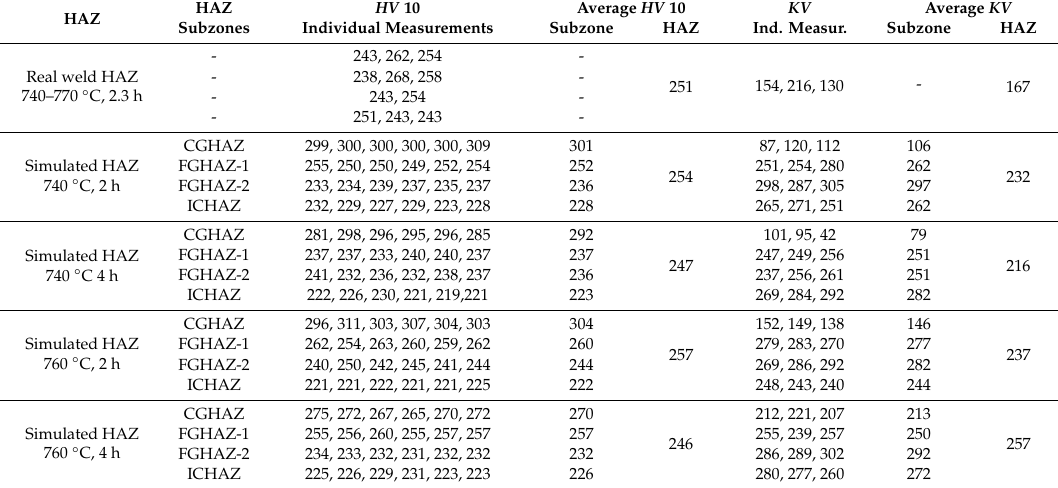
Table 5. Hardness and impact energies of real weld HAZ and simulated HAZ subzones after similar PWHTs. The values in the columns “ HV 10” and “ KV ” are the results of individual measurements. HAZ HV 10 Average HV 10 KV Average KV HAZ Subzones Individual Measurements Subzone HAZ Ind. Measur. Subzone HAZ - 243, 262, 254 Real weld HAZ 740–770 ◦ C, 2.3 h